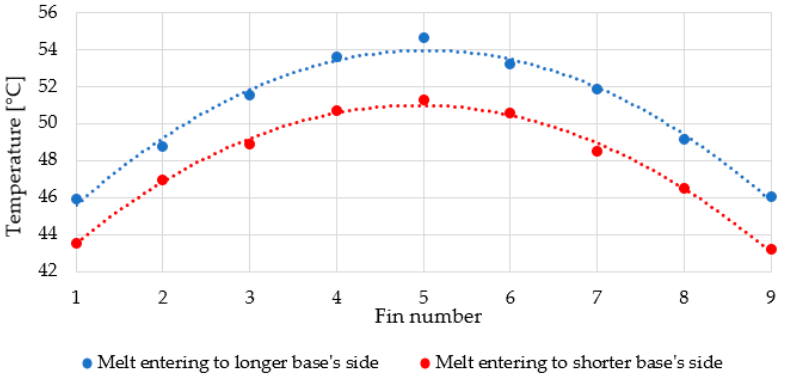
Figure 10. Heater placement in regard to the fins’ positions.